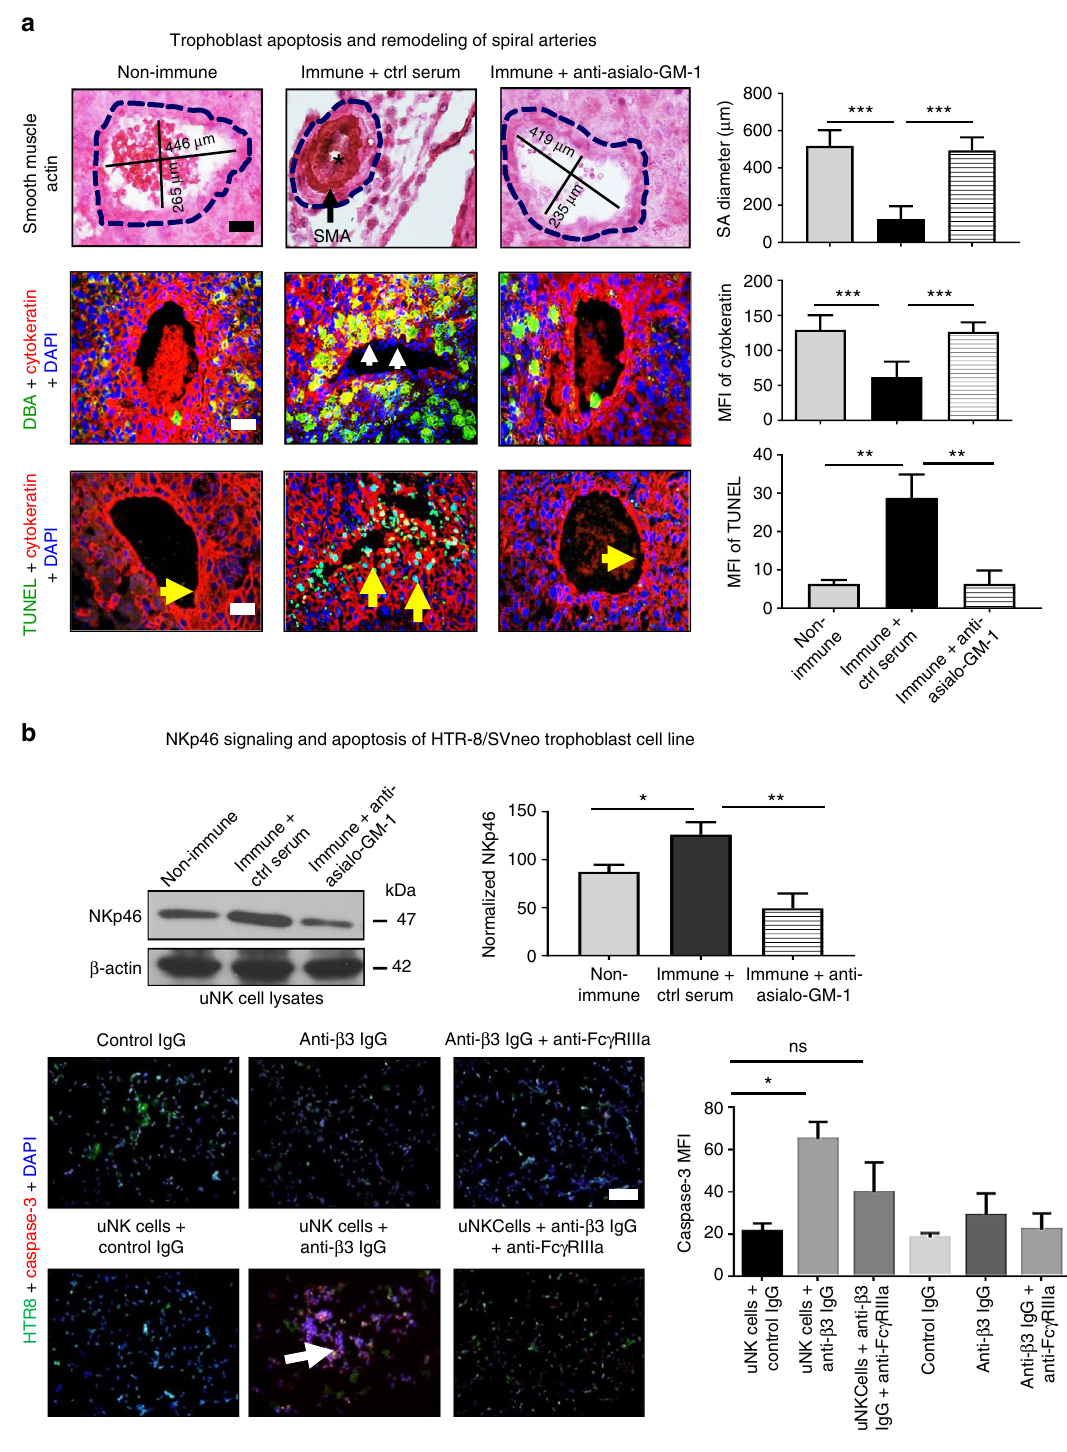
Fig. 5 Mechanisms of NK cell-mediated trophoblast apoptosis. a SA diameters were signi fi cantly larger in both non-immune and anti-asialo-GM-1-treated immune mouse placentas, whereas SA diameter was signi fi cantly reduced in placentas of non-treated immune mice, which showed higher expression of smooth muscle actin ( black arrow , top histology panel ). Spiral artery (SA) remodeling in placentas from non-immune mice showed presence of in fi ltrated endovascular trophoblasts. uNK cells surrounding maternal vessels impaired trophoblast migration into SA of immune mice. This was signi fi cantly ameliorated by anti-asialo- GM-1 treatment, which reduced NK cells ’ accumulation in the placenta ( middle immuno fl uorescence panel ). TUNEL staining of placentas from immune mice further con fi rmed apoptosis of trophoblasts surrounding SA. These abnormalities were signi fi cantly ameliorated by anti-asialo-GM-1 treatment ( bottom immuno fl uorescence panel ). b NKp46 signaling was signi fi cantly upregulated in uNK cell lysates from immune mice compared to non-immune. Anti-asialo-GM-1 treatment also reduced NKp46 expression ( top panel ). Puri fi ed uNK cells from immune pregnant mice induced antibody-mediated cell cytotoxicity on a cultured HTR-8-SV/neo trophoblast cell line, which was reduced by treatment with anti-Fc ɣ RIIIa antibody (2.4G2; bottom panel ). In vivo data are representative results of fi ve pregnancies per group at E14.5 ( a , b ), whereas in vitro data are four sets of experiments ( b ). Unpaired Student ’ s t-test. ( a ); two-way ANOVA followed by Bonferroni post hoc test ( b ). Mean ± SEM. * p < 0.05, ** p < 0.01, *** p < 0.001, ns not signi fi cant. Scale bars : 50 μ m ( a ) and 200 μ m ( b